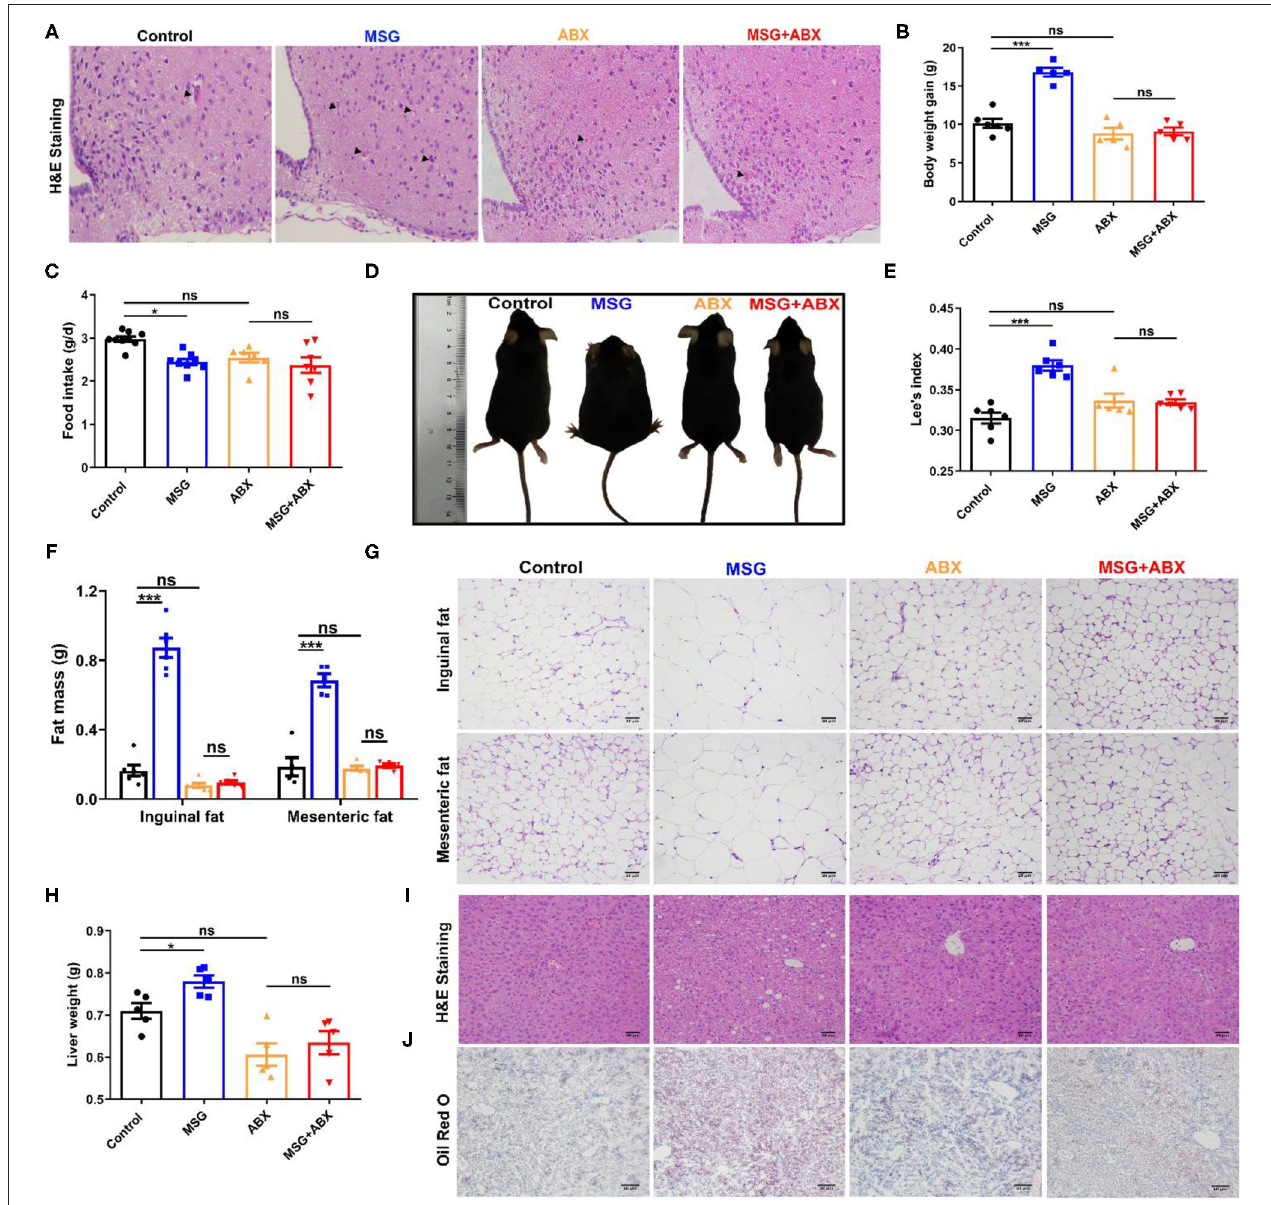
FIGURE 1 | MSG-induced abdominal obesity is counteracted by ABX treatment. (A) H&E staining in the arcuate nucleus of hypothalamus. (B) Body weight gain. (C) Food intake per day. (D) Mice morphology. (E) Lee’s index. (F) Fat mass and (G) H&E staining of inguinal and mesenteric adipose tissues. Scale bar: 20 µ m. (H) Liver weight. (I) H&E staining of liver tissues. Scale bar: 20 µ m. (J) Oil Red O staining of liver tissues. Scale bar: 50 µ m. Data are presented as mean ± SEM, n = 5–6. Data were analyzed by two-way ANOVA followed by post-hoc LSD tests. * p < 0.05, *** p < 0.001, ns, no significance. Arrowheads indicate eosinophilic neurons.